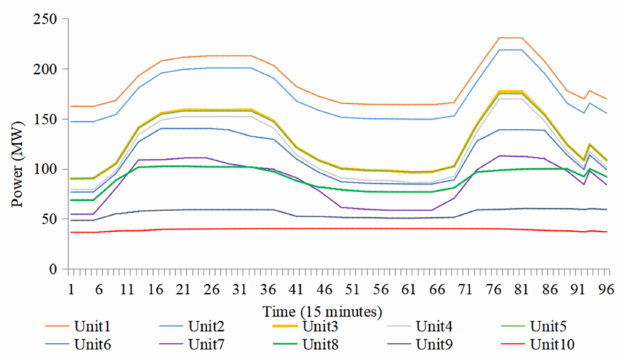
Figure 20. The power outputs of thermal generators in Case 3.